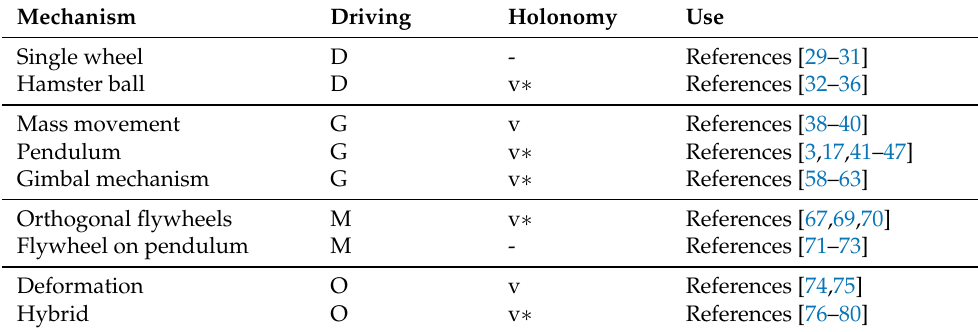
Table 1. An overview of applied SR mechanisms in existing papers.